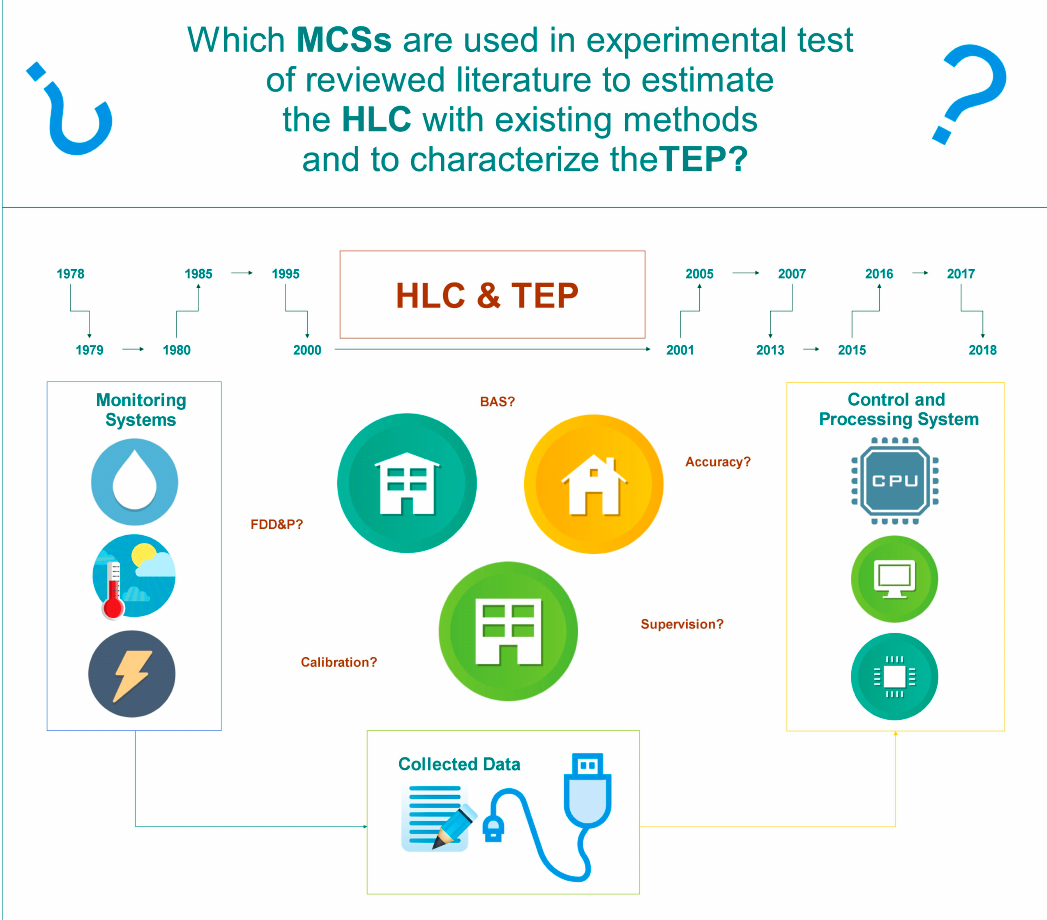
Figure 1. Abbreviated outline of Section 2: Materials and